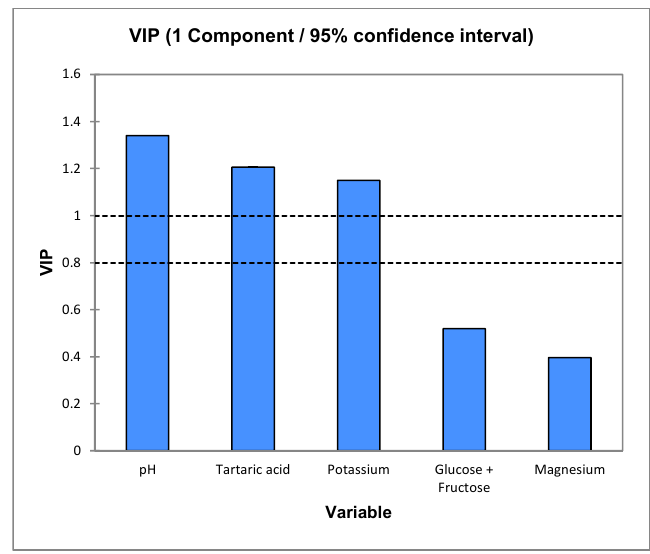
Figure 4. Standardized coefficients of the linear regression model for the gustatory “minerality” descriptor in the eleven white wines of the study constructed on the chemical profile.